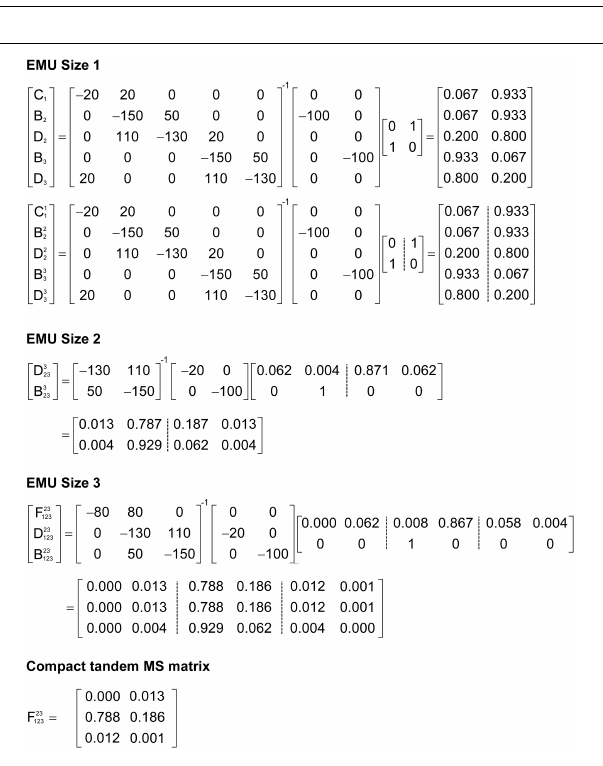
FIGURE 7 | EMU balances for simulation of tandem MS data in the simple example network model (shown in Figure 5 ). The EMU balances were constructed based on the EMU model decomposition shown in Table 2 .